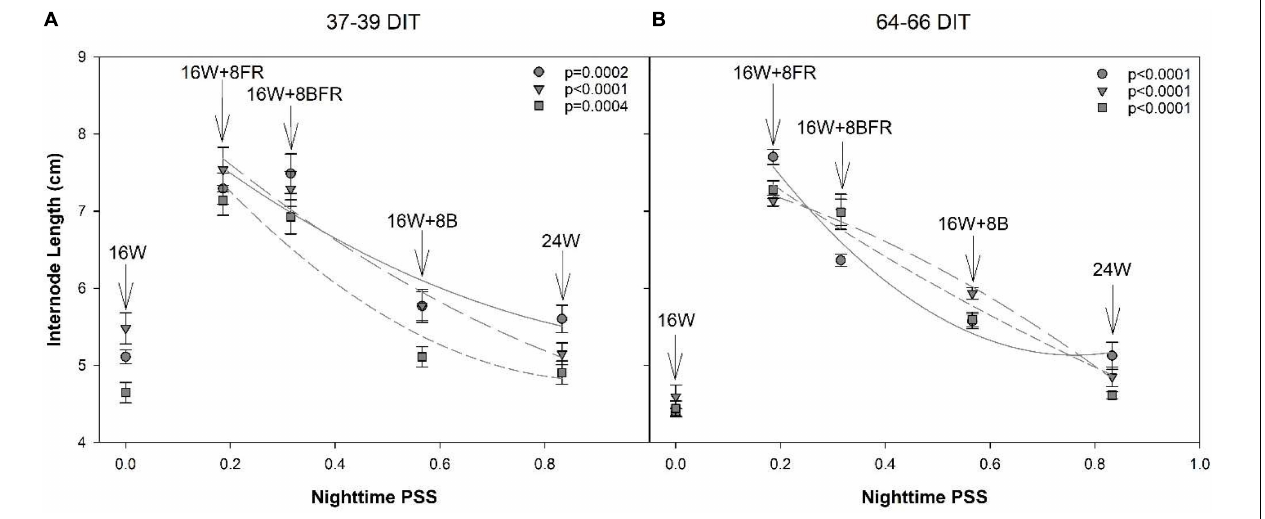
FIGURE 11 | Regression analysis of internode length from ‘Maureno’ (circle; solid line), ‘Gina’ (downward triangle; long dash line), and ‘Eurix’ (square; short dash line) during the 37–39 DIT measurements (A) and 64–66 DIT measurements (B) . Nighttime PSS of 0.833, 0.566, 0.315, and 0.186 correspond to treatments 24W, 16W + 8B, 16W + 8BFR, and 16W + 8FR respectively as determined via Sager et al. (1988). Regression analysis was done using a backward elimination method. The p -values listed are for the final regressions and only regressions which were determined to be significant ( p < 0.05) are shown. The 16W treatment did not have light at the night and thus was non-resultant during the PSS calculation. Therefore, it was left out of the regression analysis. The internode lengths for 16W are plotted in the graph at a PSS value of